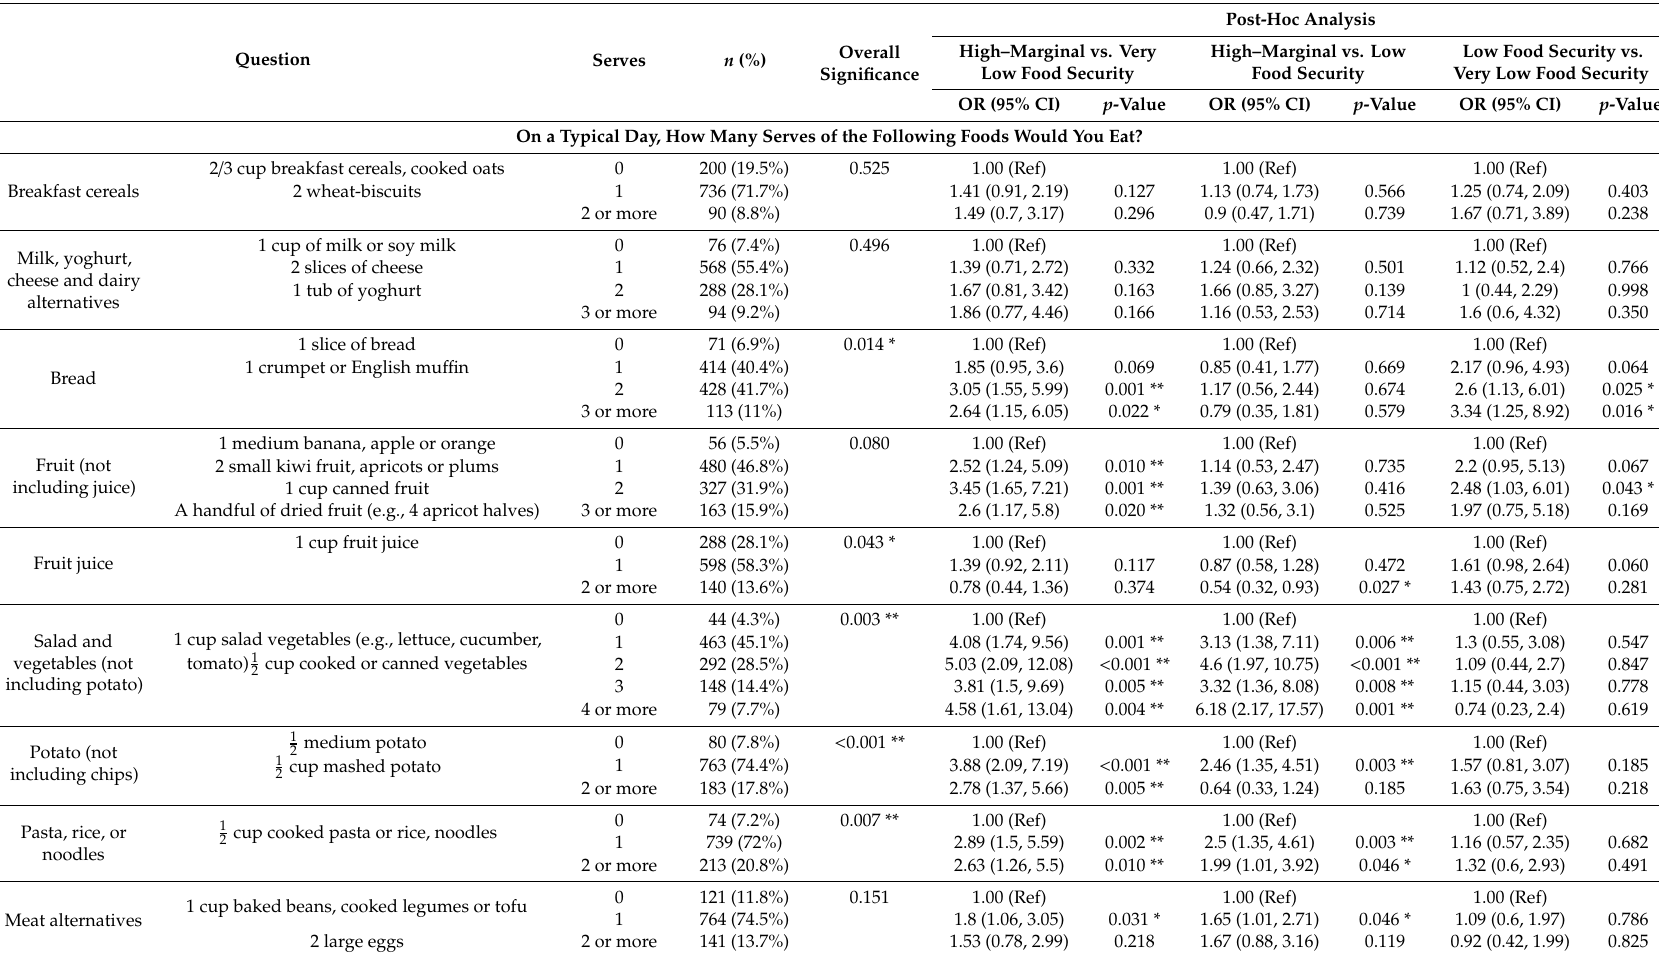
Table 4. Consumption behaviours related to food and beverages (with example serve sizes a given) by food security status.